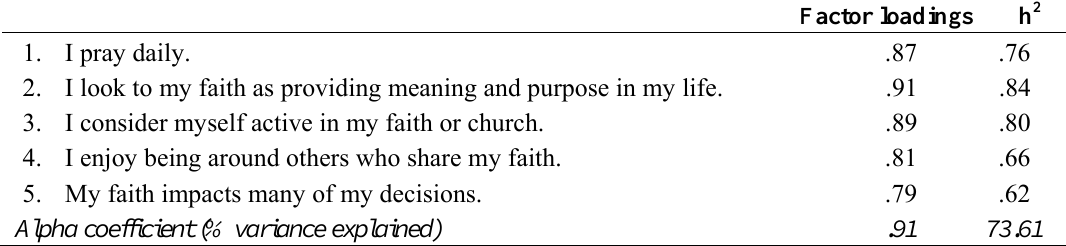
Table 4 . Factor Loadings and Communalities for the Santa Clara Strength of Religious Faith Questionnaire-SF.